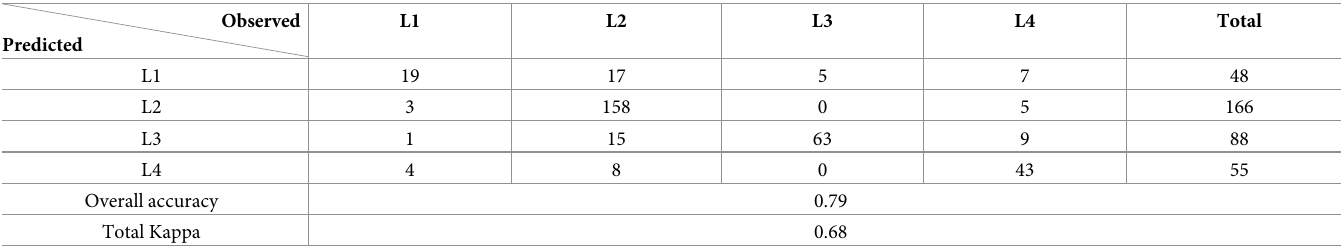
Table 8. Accuracy table of feature information extraction based on CART classifier. Observed